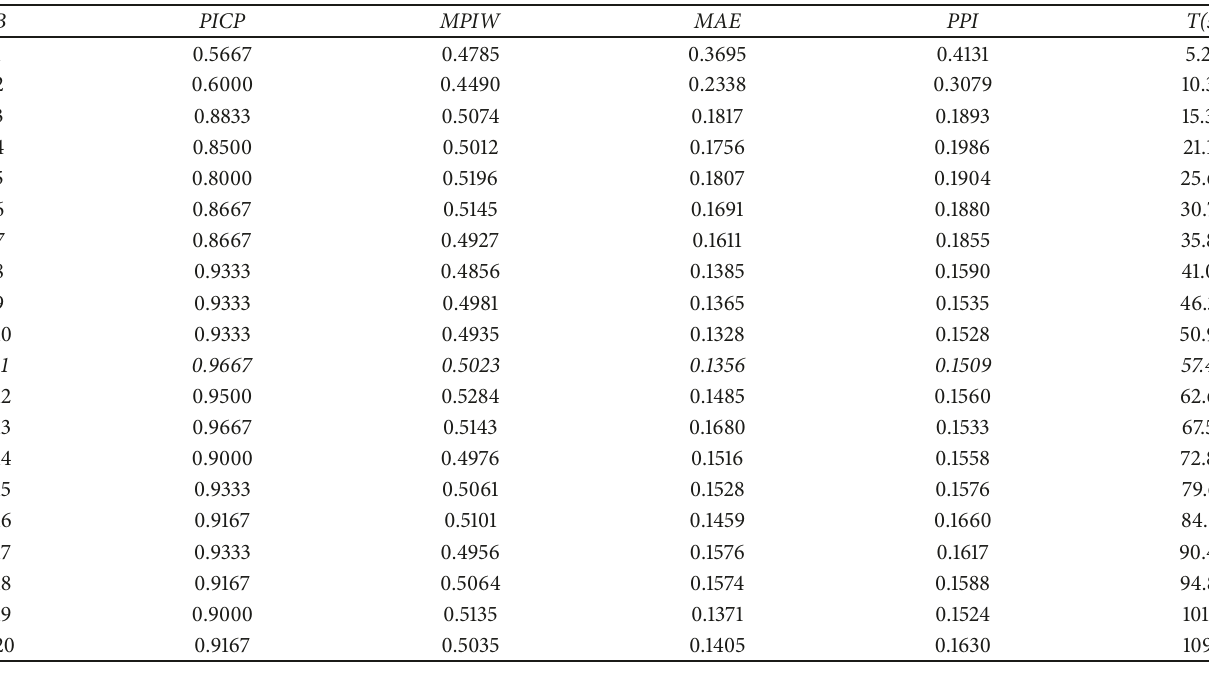
Table 1: The validation result of the number of local networks.